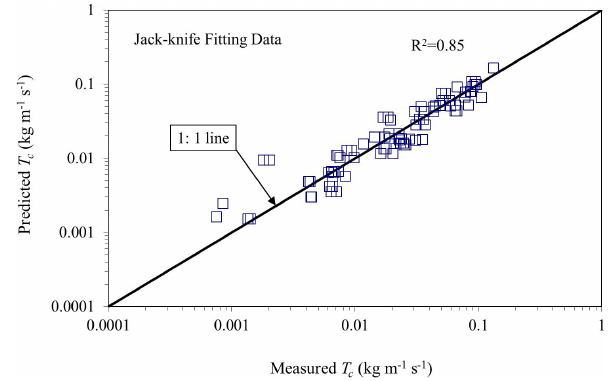
Fig. 6. Comparison between measured and predicted sediment transport capacities by using Eq. (8) when the jack-knife approach is